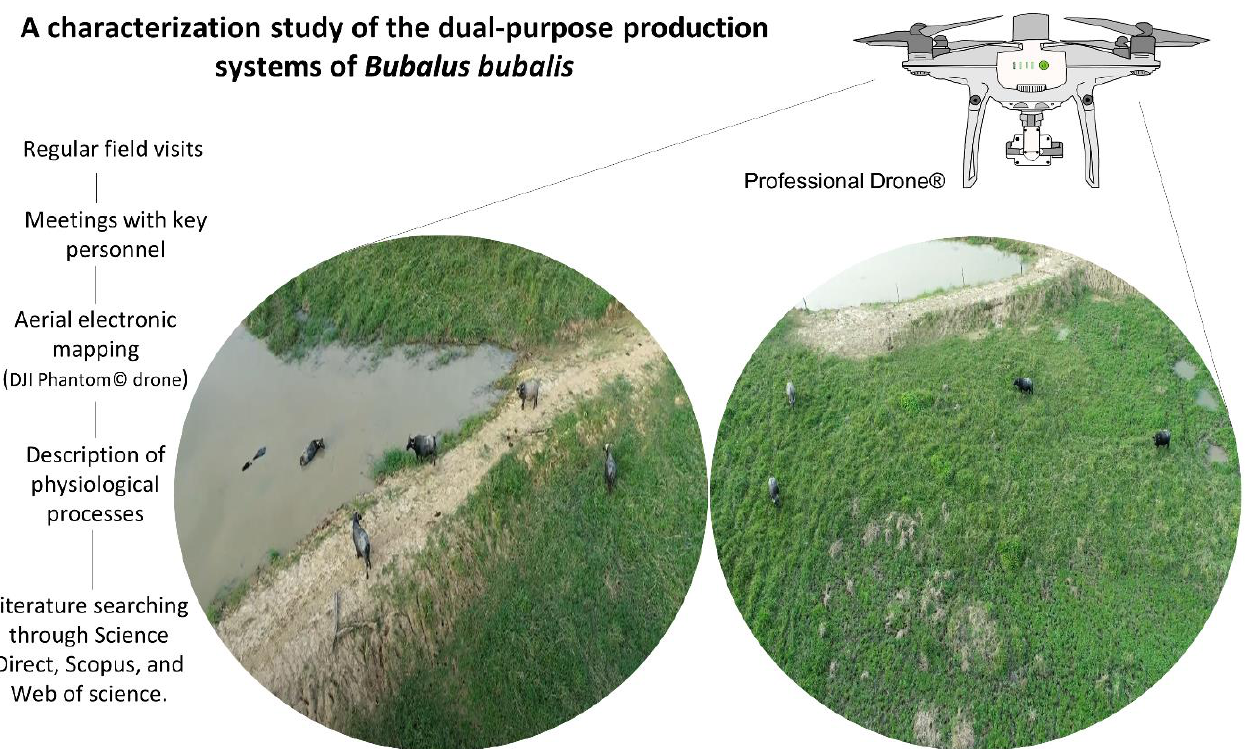
Figure 1. Methodology to obtain the data and describe the dynamic process in the dual-purpose production system of water buffaloes (17°38 ′ 54.0 ″ N 94°36 ′ 05.0 ″ W). Signs of estrus and parturition are facilitated by this method. The data obtained through regular field visits and aerial mapping with a DJI Phantom 4 Pro V2.0, DJI, Shenzhen, China, drone were compared to recently published scientific references.